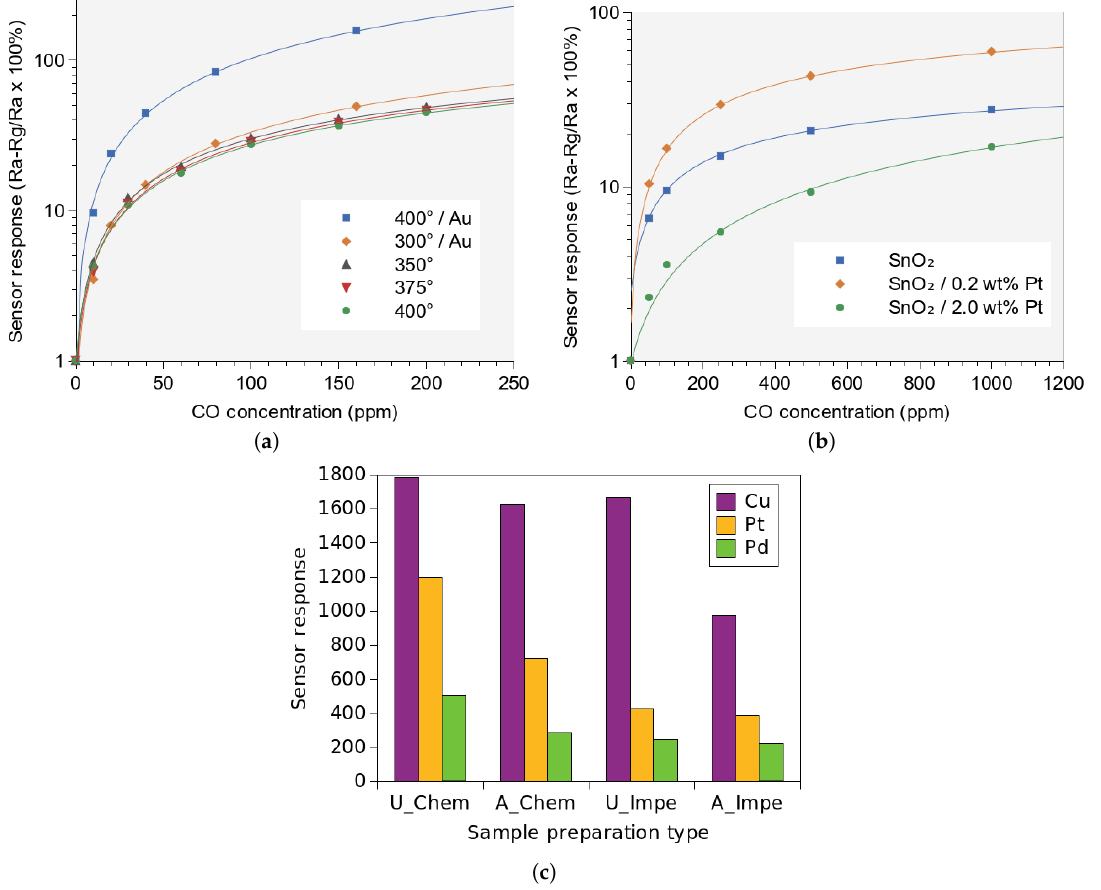
Figure 3. Sensing response of an SnO2 film after exposure to carbon monoxide from several publications. ( a ) Köck et al. [74,75] show the influence of temperature and gold doping on the operation of a 50 nm thin film. ( b ) Mädler et al. [77] show the role that platinum (Pt) doping plays on CO detection. ( c ) Tangirala et al. [78] study the influence of dopants and doping methods on the sensitivity of SnO 2 films towards the detection of